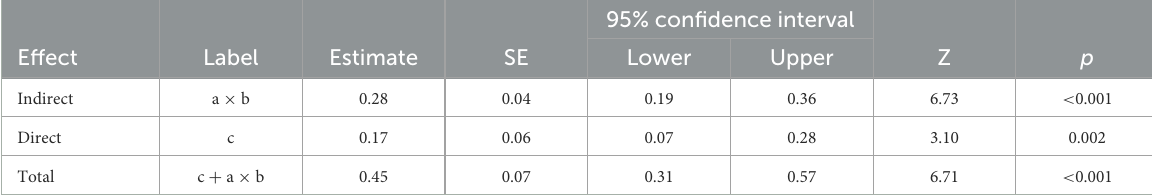
TABLE 6 Mediation estimates for the present